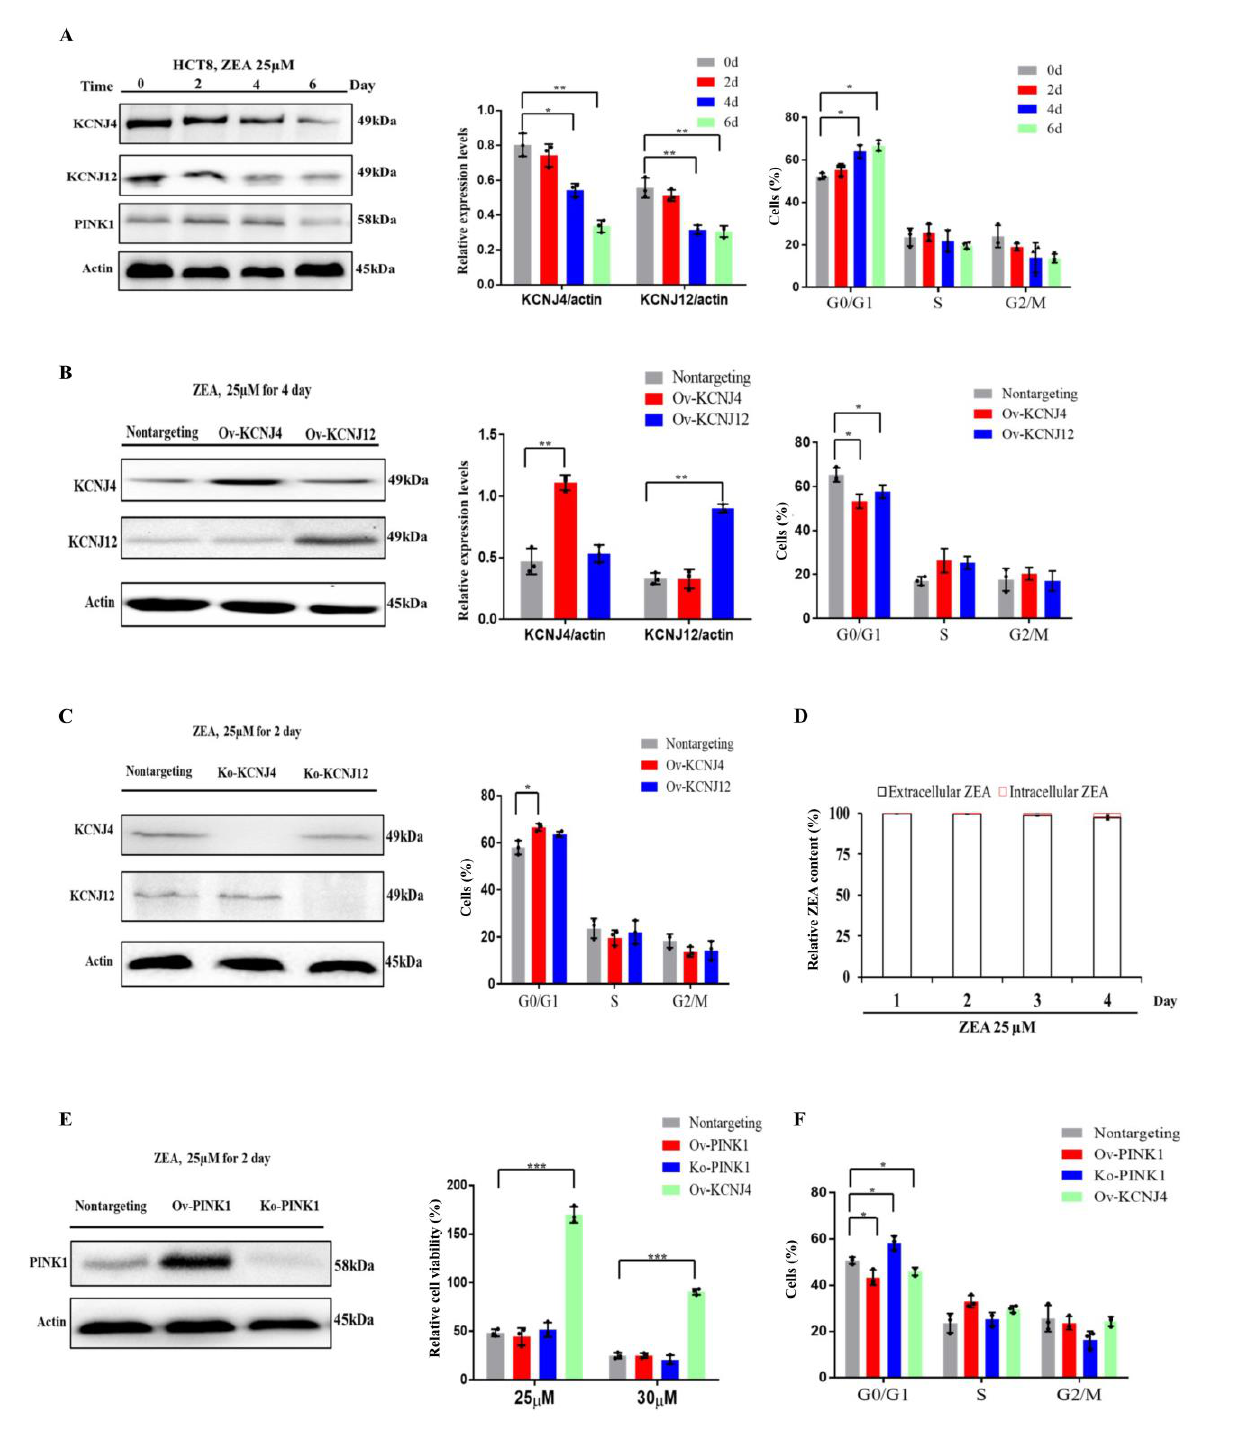
FIGURE 3: ZEA blocks cell cycle progression through targeting the potassium channels in the early stages of ZEA treatment. (A) Immunob- lotting for KCNJ4, KCNJ12, PINK1 and actin expression after ZEA treatment as well as assessment of cell cycle progression in HCT-8. (B) Im- munoblotting for KCNJ4, KCNJ12 and actin expression after ZEA treatment as well as assessment of cell cycle progression in overexpression cell lines. (C) Immunoblotting for KCNJ4, KCNJ12 and actin expression after ZEA treatment as well as their cell cycle in knockout cell lines. (D) ZEA toxin relative concentrations (extracellular and intracellular) in HCT-8 cells exposed to ZEA toxin. (E) Knockout and overexpression of PINK1 and the percentage cellular viability of cell lines after treatment with either 25 or 30 µM of ZEA. (F) Knockout and overexpression of PINK1 and assessment of cell cycle progression. Data are presented as the mean ± SEM (n=3). p < 0.05 (*), p < 0.01 (**) and p < 0.001 (***), calculated by Student